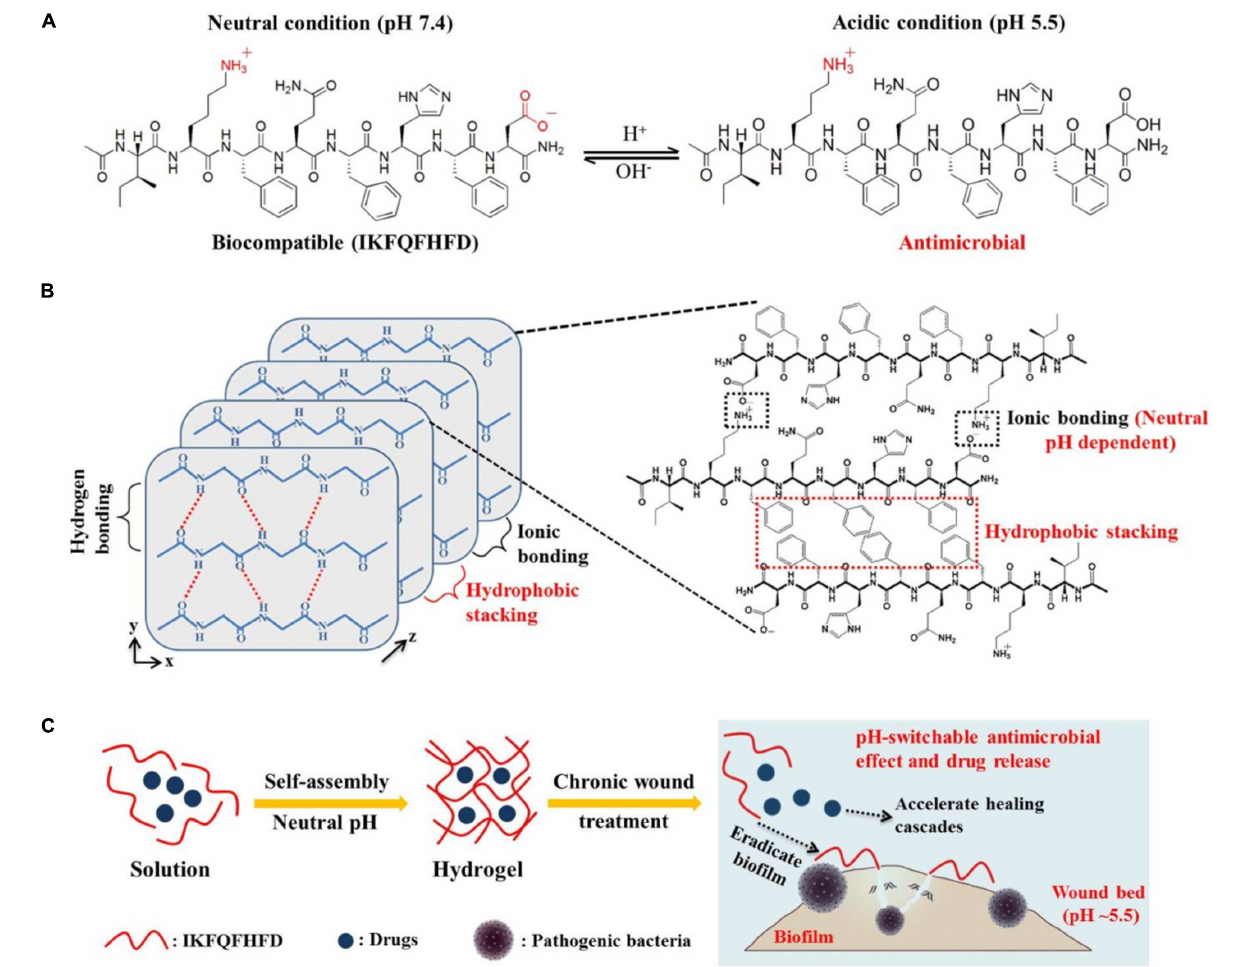
FIGURE 11 | (A) Peptide sequence of IKFQFHFD under neutral and acidic conditions. (B) Principle of IKFQFHFD to form self-assembled nanofiber networks hydrogel at neutral pH. (C) Conceptual illustration of self-assembled nanofiber networks hydrogel for biofilm eradication and therapy method in a chronic wound (Wang et al., 2019a). Copyright 2019, American Chemical